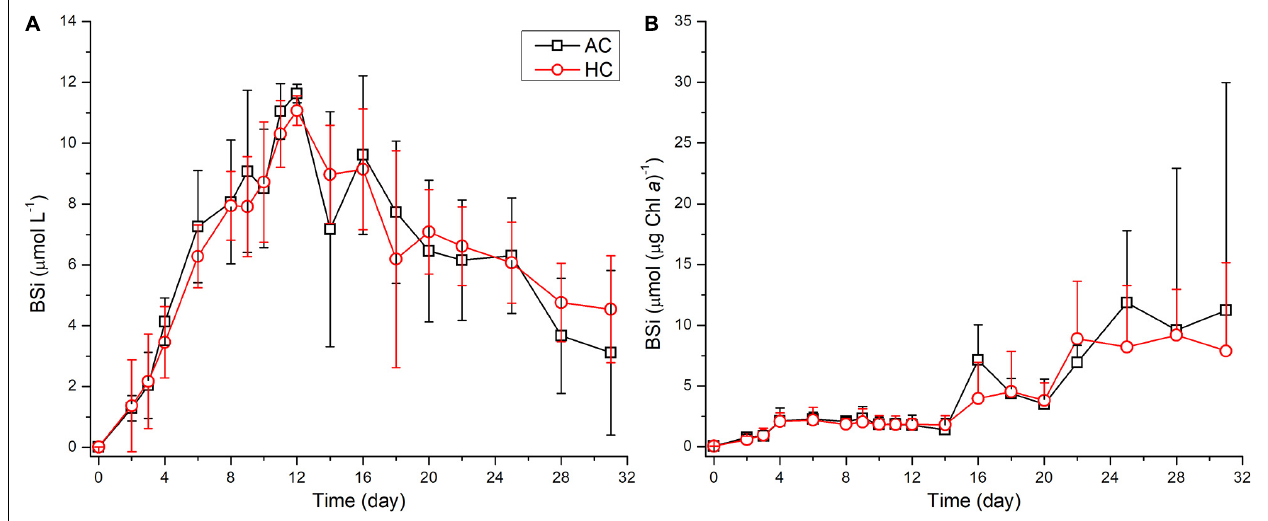
FIGURE 8 | Temporal variations of biogenic silica concentration in the water (A) and biogenic silica contents normalized to Chl a (B) , in HC (1000 ppm) and AC ( ∼ 410 ppm) treatments. Data are means ± SD (A) or means ± SD (B) of replicates for HC treatments and for AC